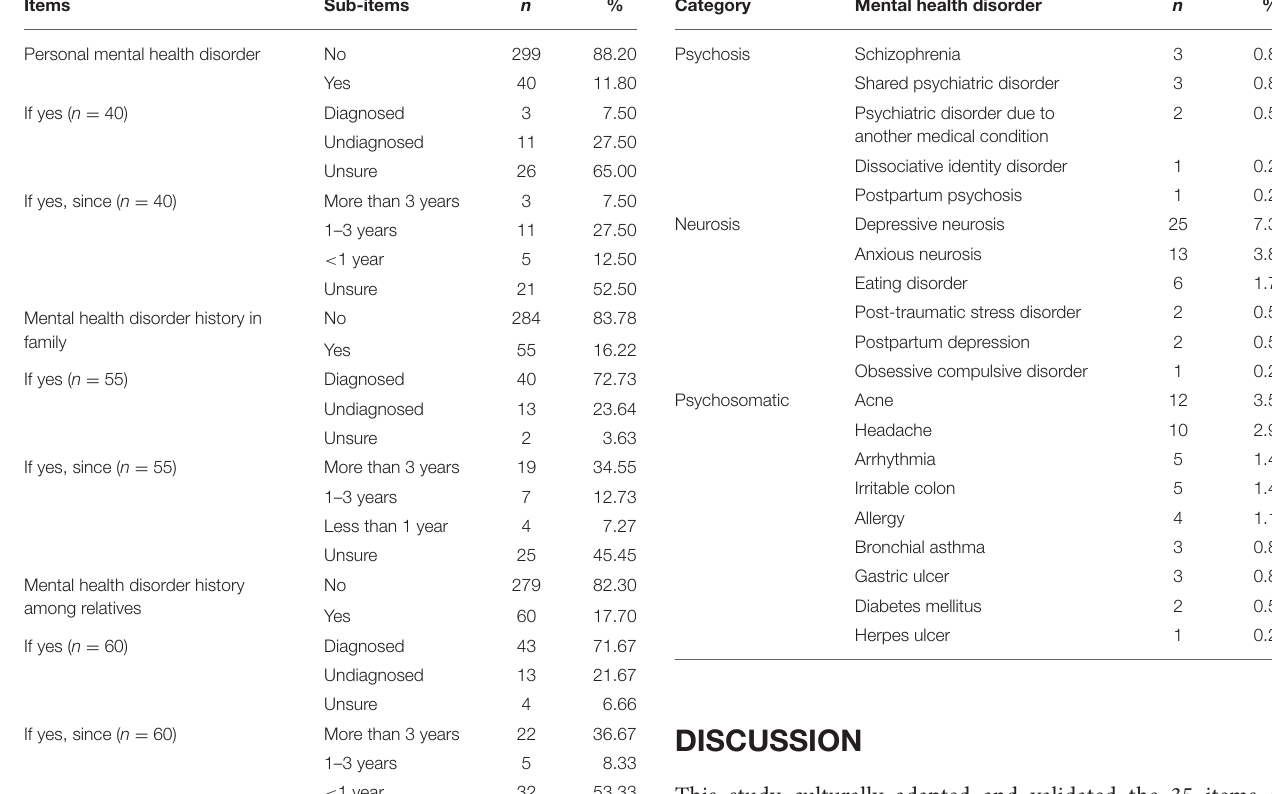
TABLE 3 | Mental health disorder history of Saudi university students, their families and relatives ( N = 339). Items